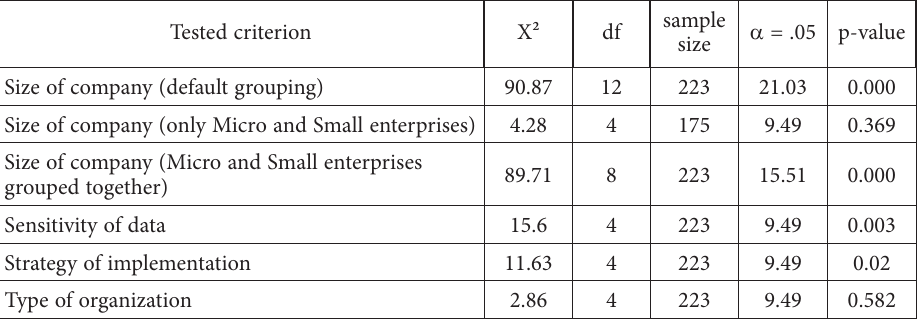
Table 2. Test of independence